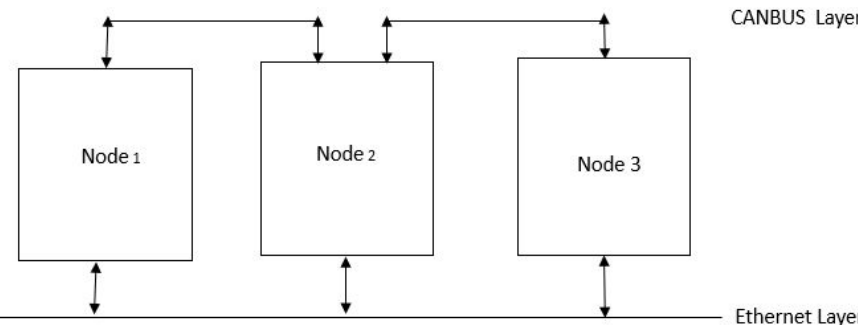
Figure 4. The lab setup with CAN and Ethernet bus